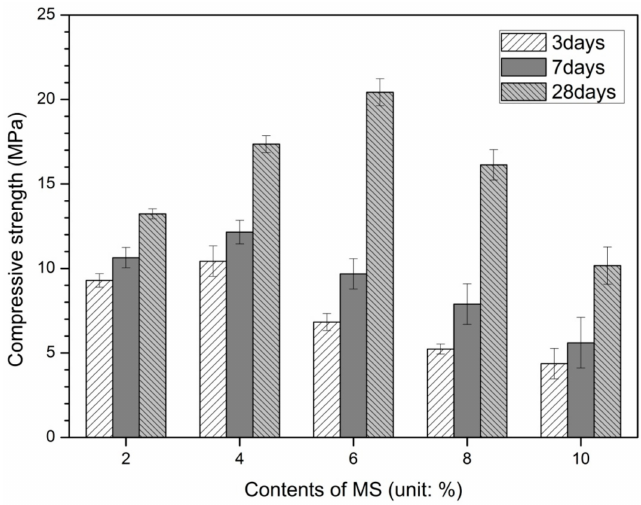
Figure 1. Compressive strength according to MS